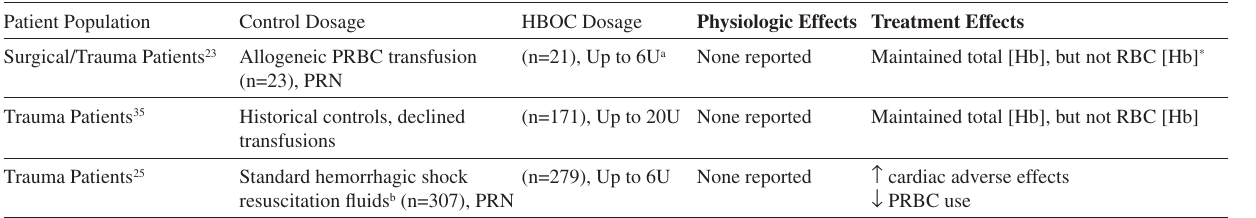
Table 3 - PolyHeme clinical trials Patient Population Control Dosage HBOC Dosage Physiologic Effects Treatment Effects Surgical/Trauma Patients 23 Allogeneic PRBC transfusion (n=23),